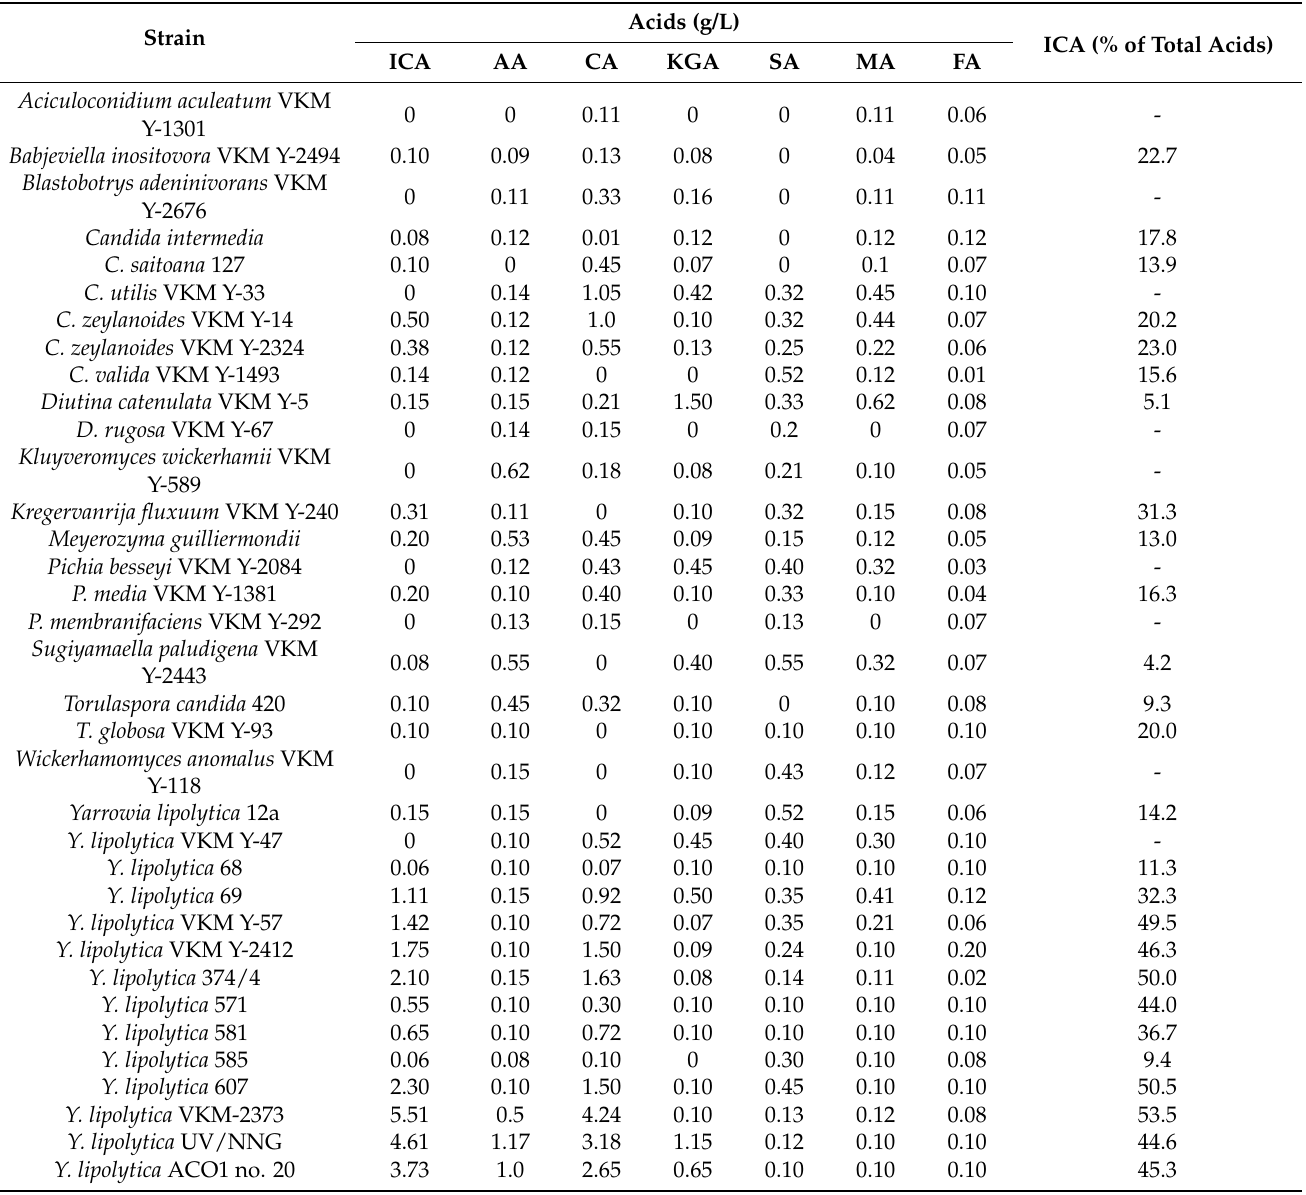
Table 1. Acid production by yeast in the medium containing EAF as a carbon source under nitrogen limitation. Acids (g/L) Strain ICA (% of Total Acids) ICA AA CA KGA FA